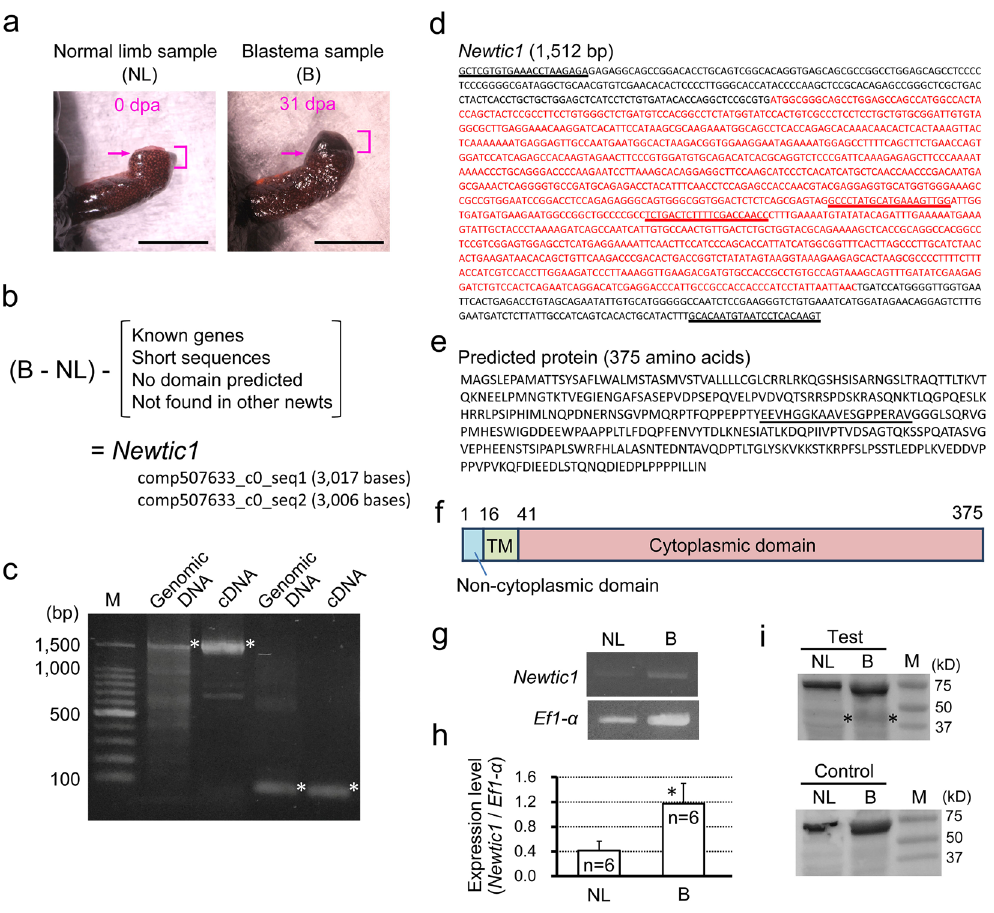
Figure 1. Identification of Newtic1. ( a ) Tissue sampling. For normal limb (NL), tissues in the region up to 1.5 mm proximal to the amputation plane were harvested immediately after the limb was amputated in the middle of the forearm (0 day post-amputation (dpa)). For the blastema (B), samples at stages I to III (see Fig. 4a) were harvested by sectioning the limb at the location of amputation. Scale bars, 5 mm. ( b ) In silico screening of unique genes specific to the blastema (Supplementary Figures S3 and S4). We finally obtained a gene Newtic1 . ( c ) Confirmation of the existence of Newtic1 (n = 3). PCR products (1,512 bp and 76 bp) were obtained in both genomic DNA and blastema cDNA (asterisks). Bands were separated on the same gel. M: marker. ( d ) The confirmed sequence of Newtic1 . It was present in both the genome and cDNA. Red: open reading frame. Underlines: sequences corresponding to the primer sets for PCR in ( c , e ) Amino acid sequence of a deduced protein. Underline: epitope sequence of Newtic1 antibody. ( f ) Secondary structure of the protein. TM: transmembrane domain. ( g , h ) Expression levels of Newtic1 in NL and B. Newtic1 was amplified by PCR with NL and B cDNA samples (n = 6 each). Ef1- α was also amplified as an internal control. Full-length gel images for the data are shown in Supplementary Figure S6a. The quantity of the PCR product of Newtic1 was normalized by that of Ef1- α in the same cDNA sample. The mean expression level of Newtic1 in B was significantly higher than that in NL (Student’s t -test, * p < 0.05). Of note, weak Newtic1 expression was detected, as shown in ( g ), in 4 of 6 NL samples. ( i ) Presence of Newtic1 protein. Western blotting was carried out with the same volume of protein samples which were extracted from the same weight of NL and B samples (n = 3). The NL and B protein samples were blotted on the same membrane. Using Newtic1 antibody (Test), weak protein bands corresponding to Newtic1 (40.7 kD) were detected in both samples (asterisks), although the band intensity in the blastema was slightly higher. For the control (Control), Newtic1 antibody was replaced with RFP antibody. The membranes for Test and Control were stained separately. The 60–70 kD bands were caused by a non-specific reaction of the secondary antibody. M: